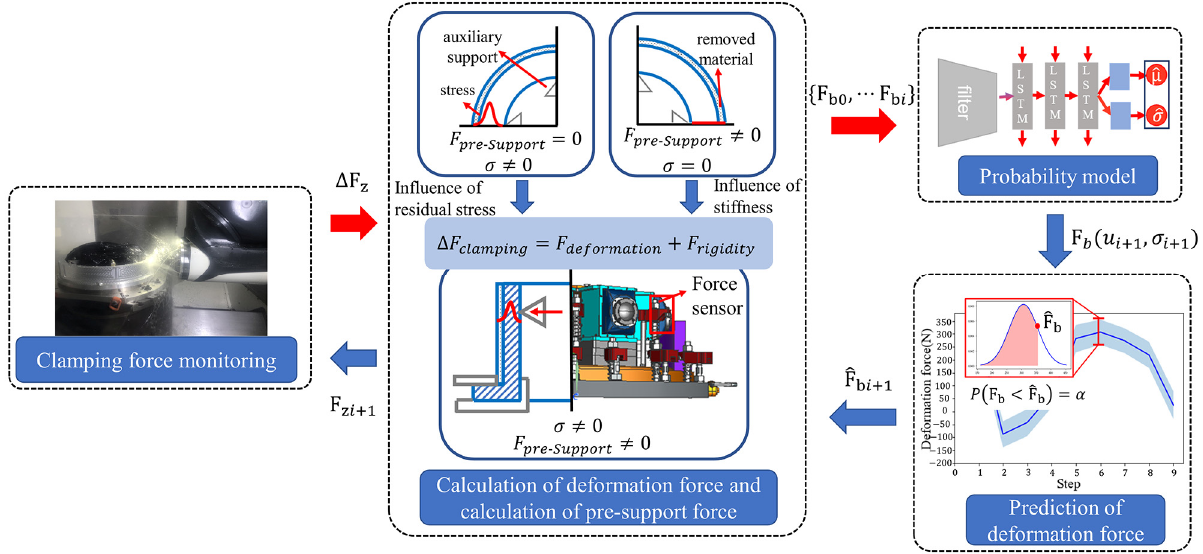
Figure 2. The proposed method for monitoring aero-engine casing’s deformation